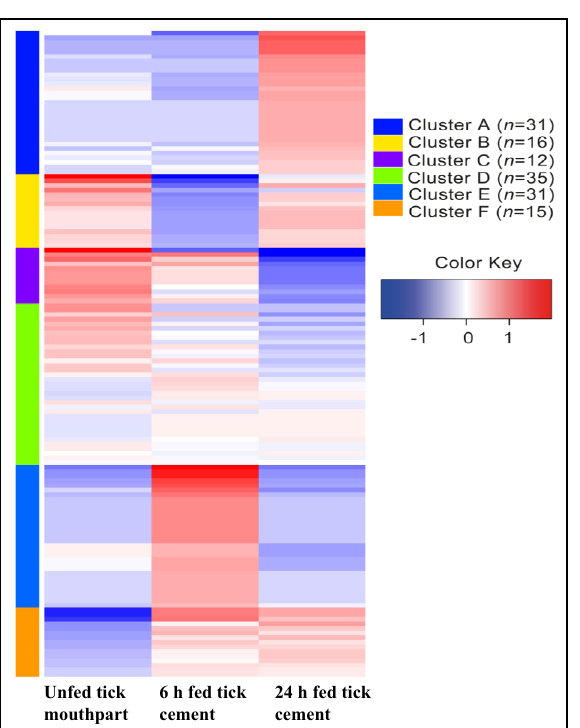
Figure 2. Relative abundance of tick cement proteins in cement of 6 and 24 h attached ticks and in mouthparts of unfed ticks. Normalized spectral abundance factor were loaded into iDEP (integrated Differential Expression and Pathway analysis; http:// ge- lab. org/ idep/) to generate the heat map. Accession numbers of tick cement proteins in different clusters of the heatmap are listed in supplemental Table